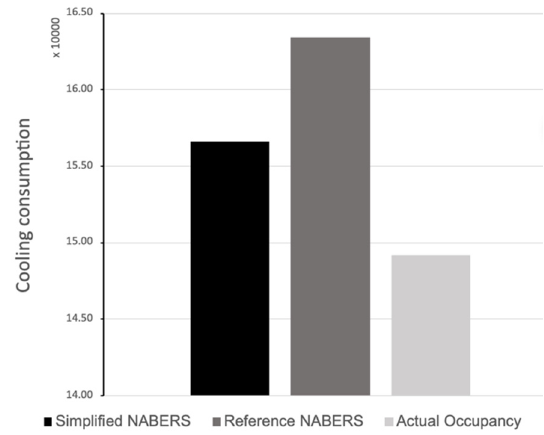
Figure 3. Total cooling consumption for the 8th floor in the three different scenarios.